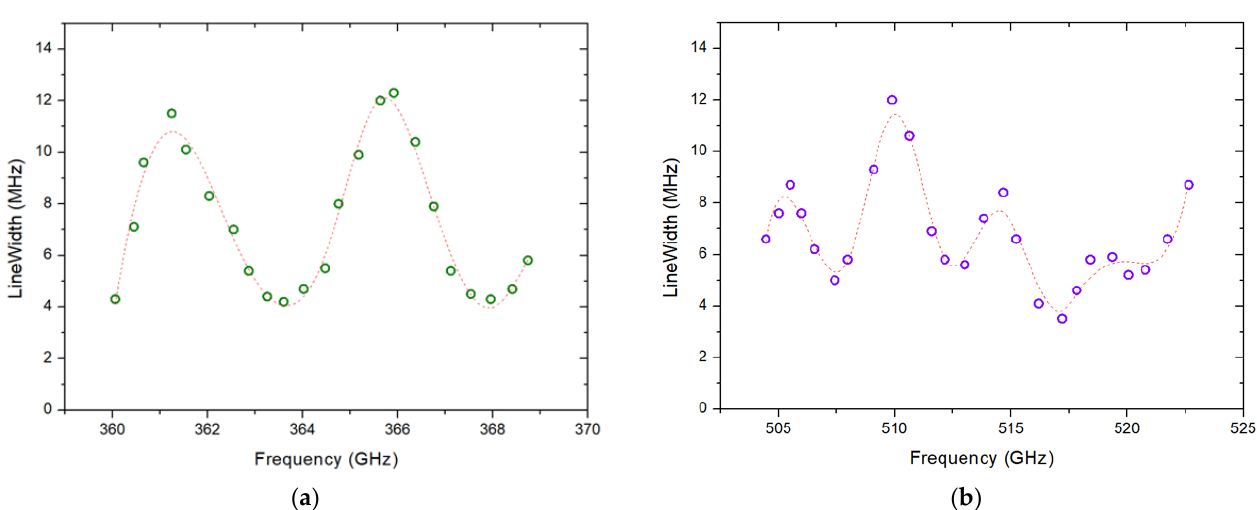
Figure 10. Down-converted spectra of the Nb-AlN-NbN FFO recorded for points A and B (see Figure 9); spectra are measured for free-running and phase-locked FFO (blue and red curves, respectively).